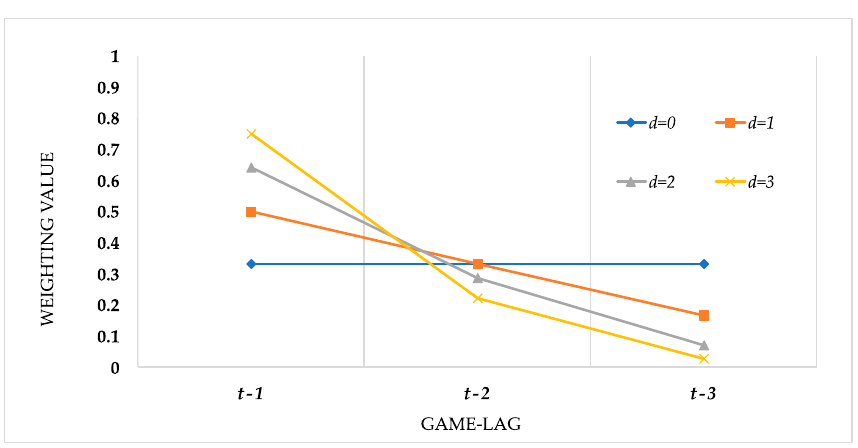
Figure 2. Weighting distribution of each data point with different weighting control parameter ( d ) from 0 to 3 under game-lag = 3.